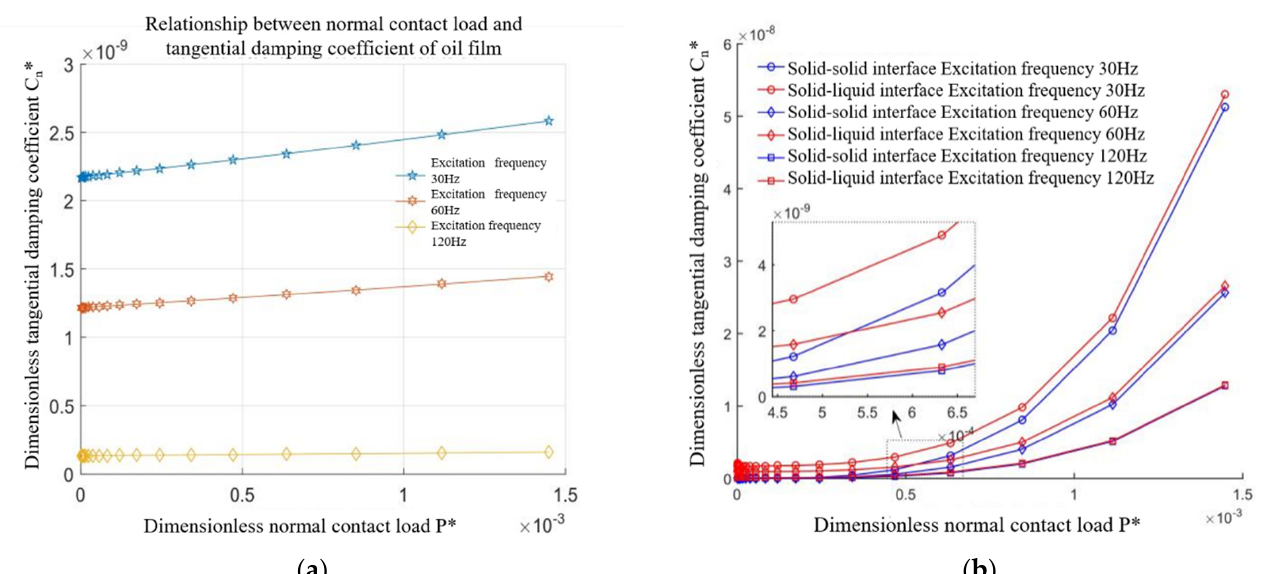
Figure 7. Relationship between the tangential damping coefficient and a normal contact load under different excitation frequencies. ( a ) Fluid contact characteristics, ( b ) solid − solid and solid–liquid bonding face ratio.